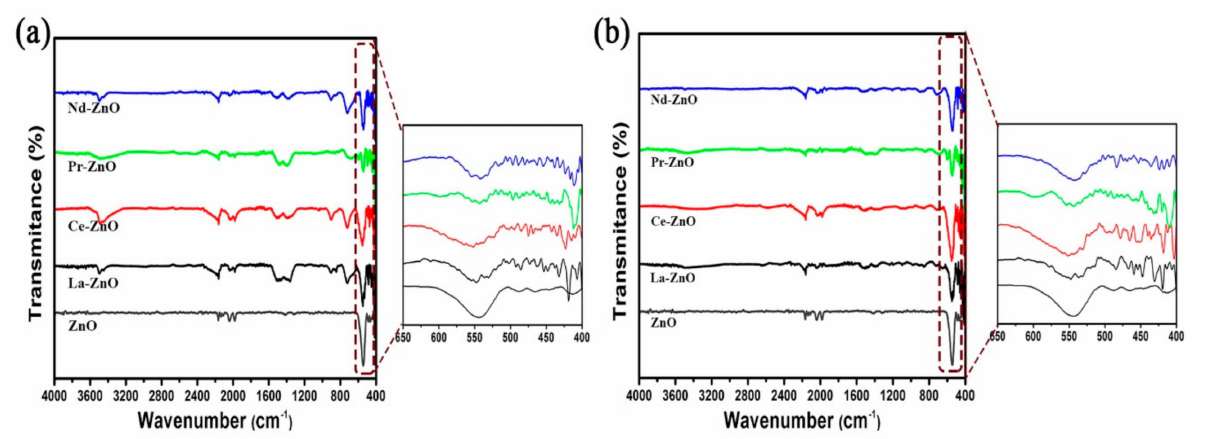
Figure 2. FTIR spectra of ZnO and M-ZnO (M = La 3+ , Ce 3+ , Pr 3+ and Nd 3+ ) nanoparticles ( a ) calcined to 500 ◦ C and ( b ) calcined to 700 ◦